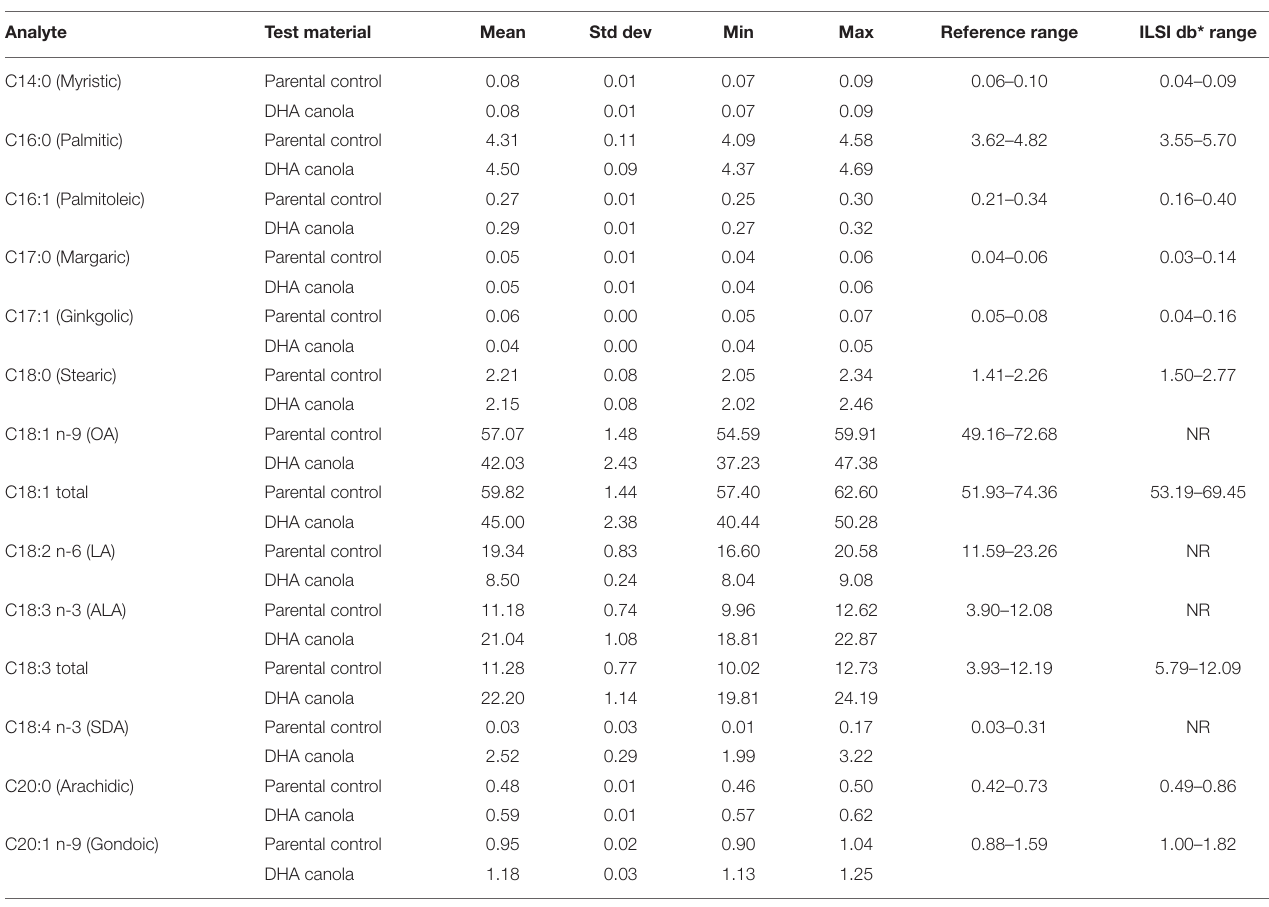
TABLE 2 | FA analysis of DHA canola grain (% of total